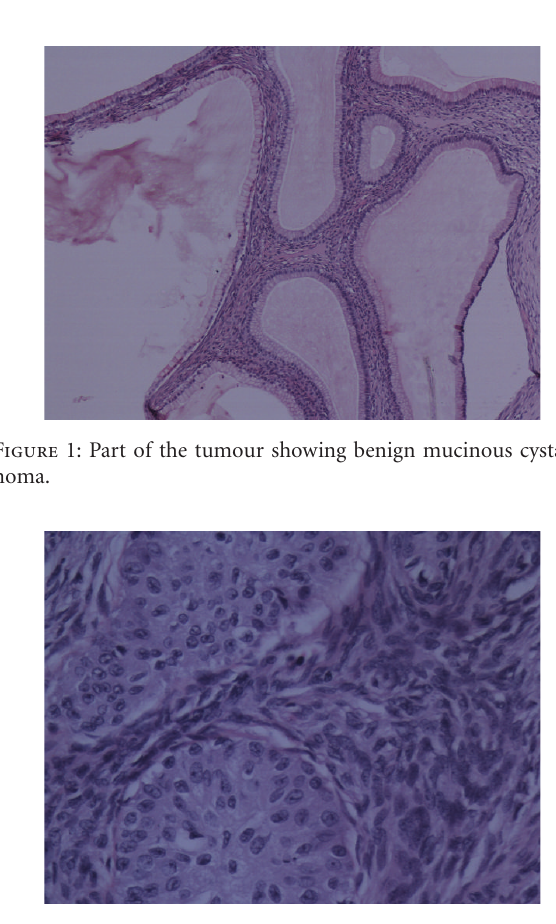
Figure 2: Part of the tumour showing Brenner tumour.